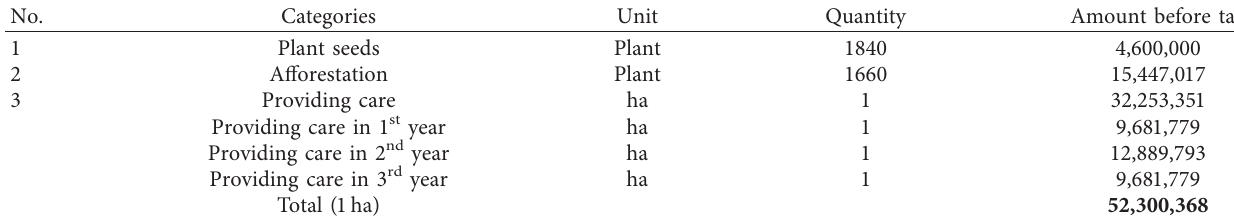
Table 2: Cost for plating 1ha of hybridized Acacia .